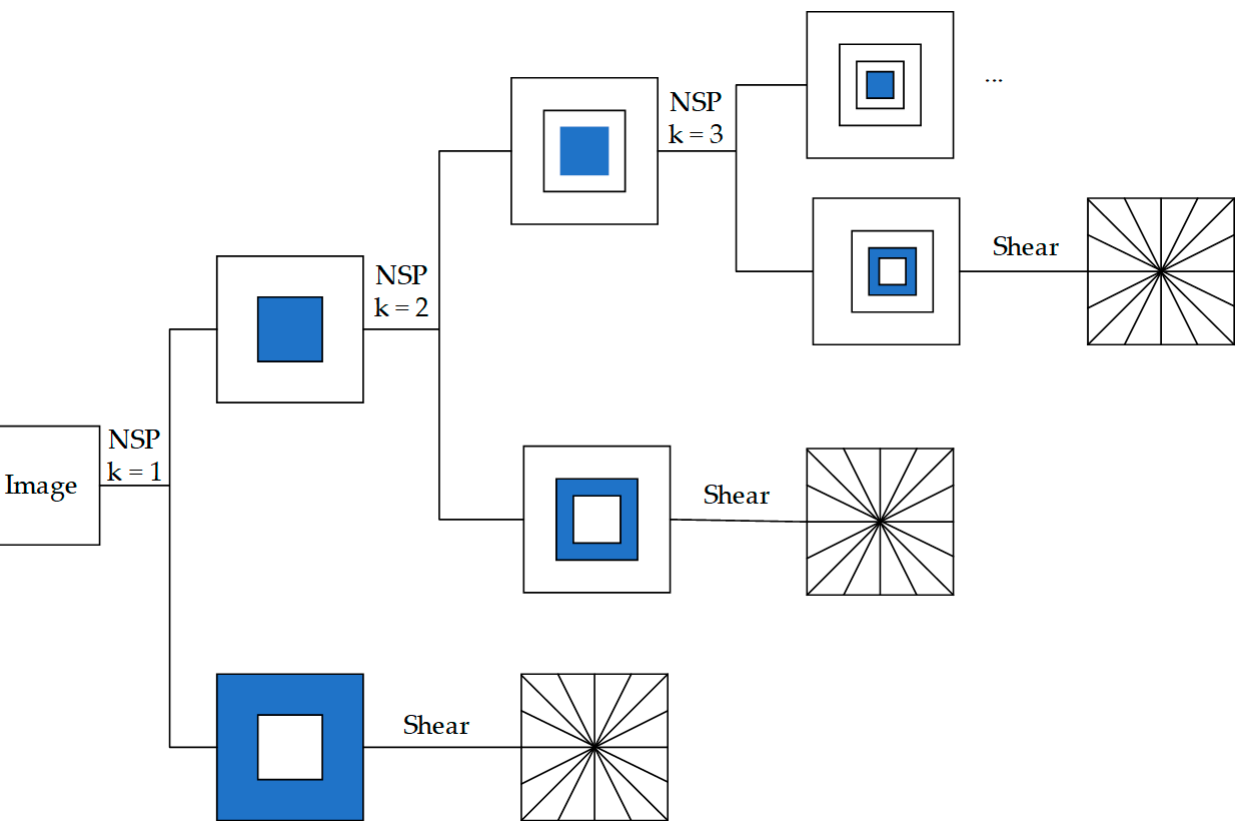
Figure 2. Three-level multi-scale and multi-directional decomposition of NSST.